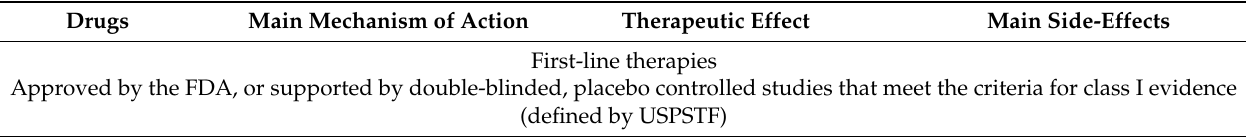
Table 1. Main drugs used in the pharmacotherapy of